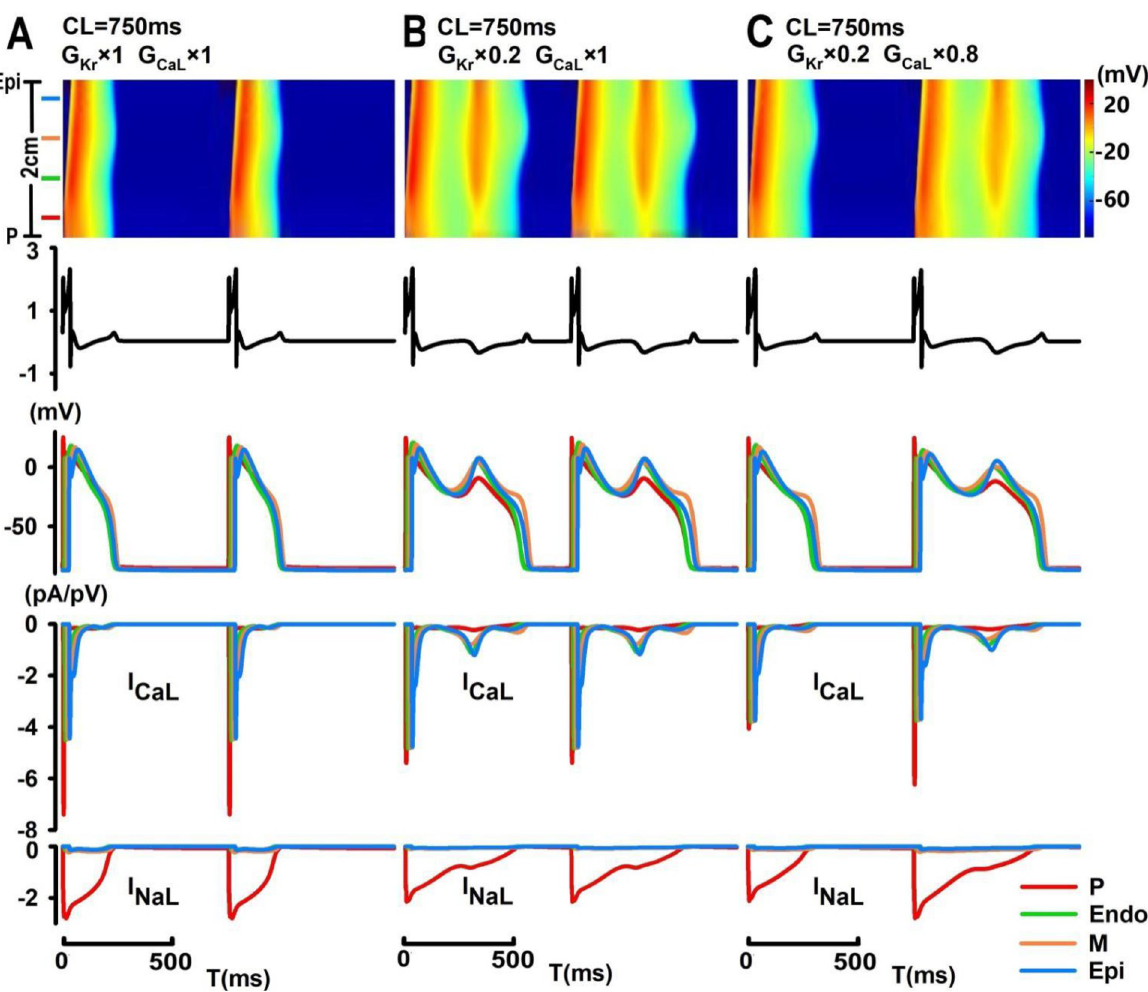
Fig 4. Computer simulation of spatially synchronized EAD events in the PVS tissue model. (A) Normal antegrade excitation of the PVS under control conditions; (B) spatially synchronized steady-state EAD events with T-wave inversion can be induced by an 80% reduction in I Kr at CL = 750 ms and degraded into beat-to-beat occurrences of spatially synchronized EADs and T-wave alternans with an additional blockade of I CaL (20%)